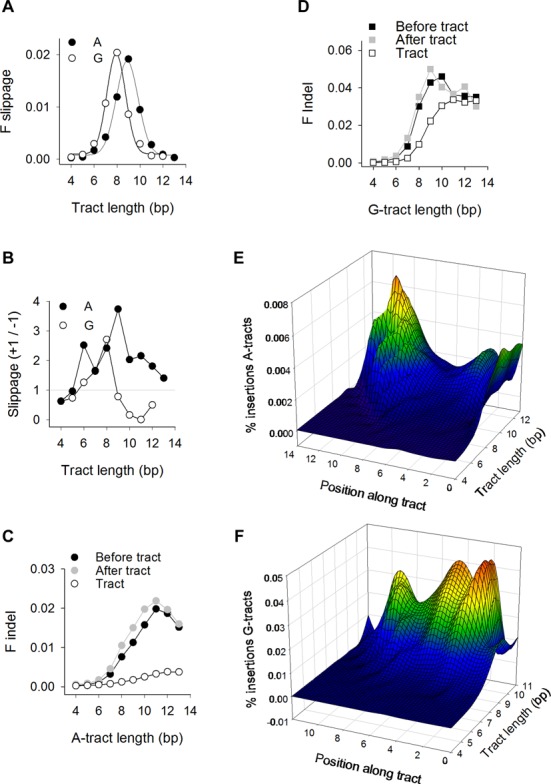
Population insertions and deletions. (A) Normalized fractions of A-tracts (closed circles) and G-tracts (open circles) displaying +/−1 bp slippage in the 1KGP dataset as a function of tract length. Data were obtained by dividing the number of events by both the number of hg19 tracts and tract length (n). (B) Ratio of the number of +1 to −1 slippage for A-tracts (closed circles) and G-tracts (open circles). (C) Indels at A-tracts. For positions along the tracts (‘Tract’), ‘F Indel’ is the ratio between the number of indels and the number of tracts in hg19 multiplied by tract length. For the positions immediately flanking the tracts genomic coordinates (‘Before tract’ and ‘After tract’), ‘F Indel’ is the ratio between the number of indels and the number of tracts in hg19. (D) Indels at G-tracts, calculated as described in panel C. (E) Heatmap representation of insertions along A-tracts. The percent insertions (i.e. the number of insertions at each position divided by the number of tracts in hg19) (y-axis) plotted as a function of location (x-axis) from position 0 (insertion between the bp 5′ to the tract and the first bp of the tract) to position n + 1 (insertion between the bp 3′ to the last bp of the tract and the following bp) (see Figure 1A) and as a function of tract length (z-axis). (F) Heatmap representation of insertions along G-tracts.